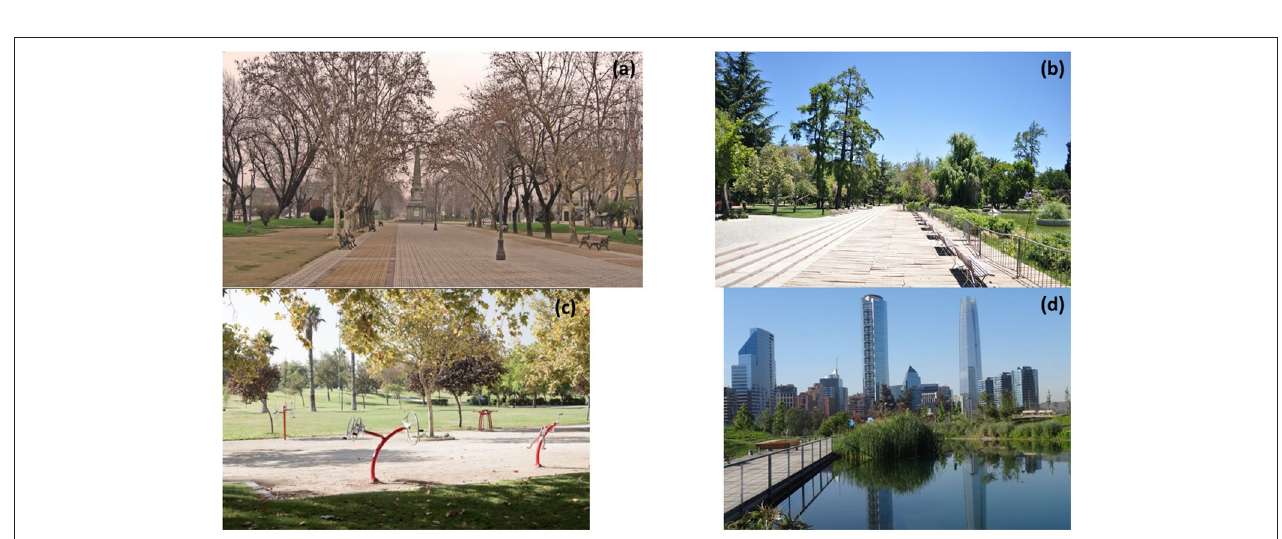
FIGURE 2 | Percentage of housing units in Talca with irrecoverable housing materials, an indicator of housing quality (2017).